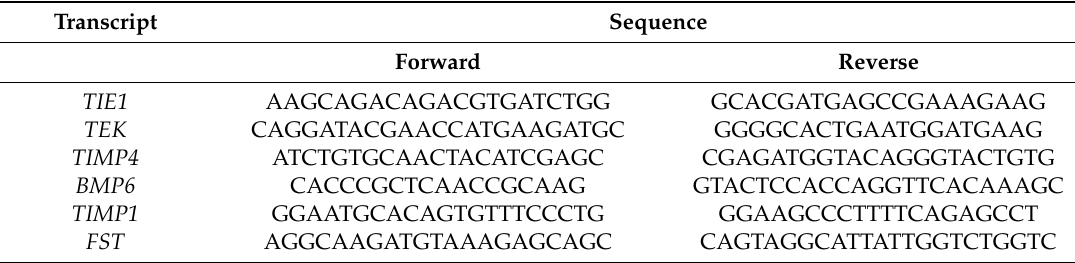
Table A1. Primers sequences for quantitative RT-PCR.